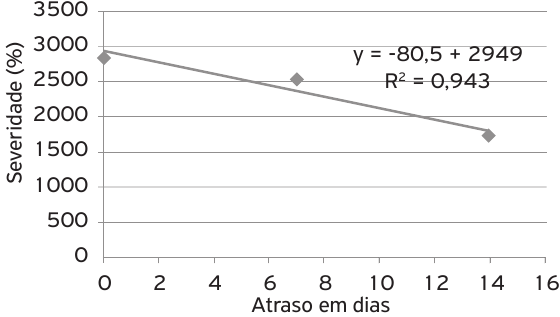
Figura 3. Regressão entre os índices de produtividade e o atraso em dias para a aplicação de fungicida para controle da ferrugem da folha do